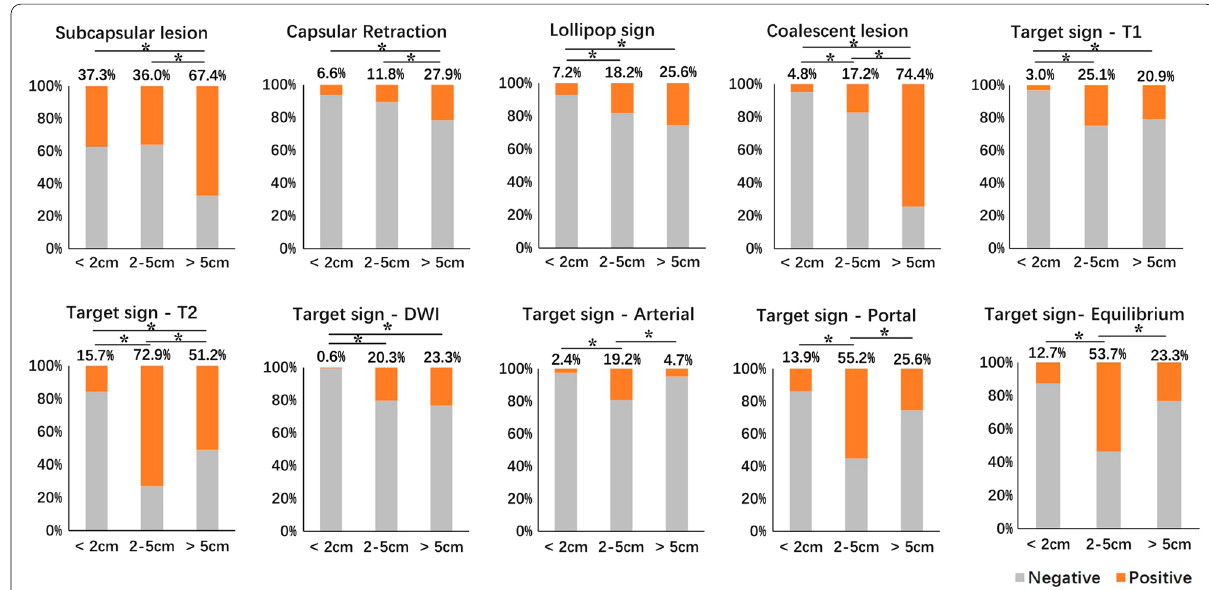
Fig. 3 The comparison results of different MRI features among lesions of different